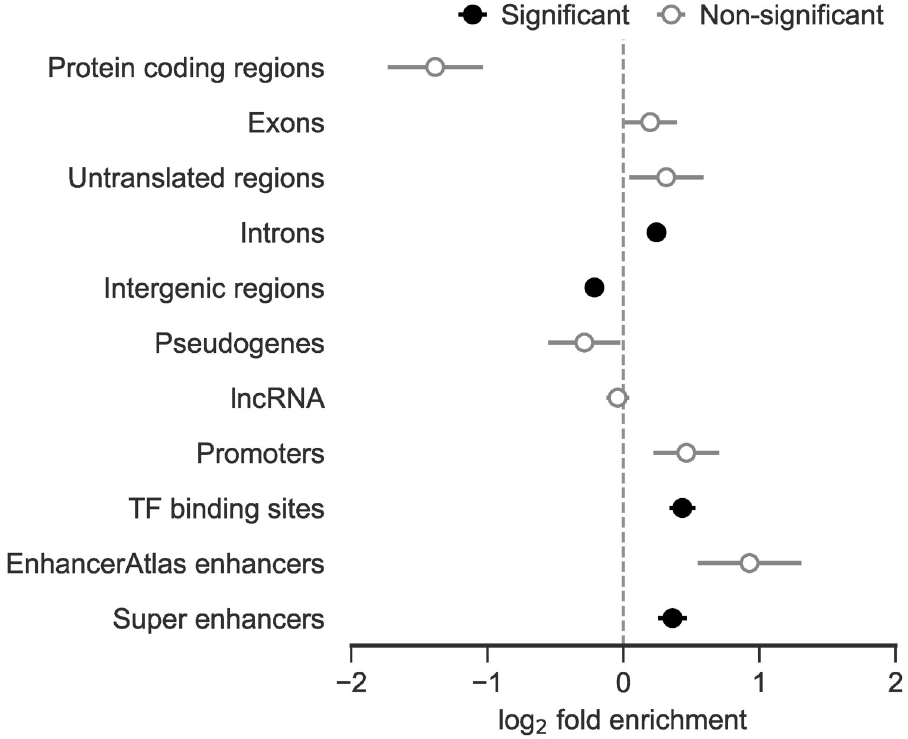
Fig 6. Enrichment or depletion of gold-standard events within various human genomic elements. Error bars reflect standard deviations of the log 2 -fold changes from each test. A significance threshold was set at 0.01 for Bonferroni- corrected empirical p